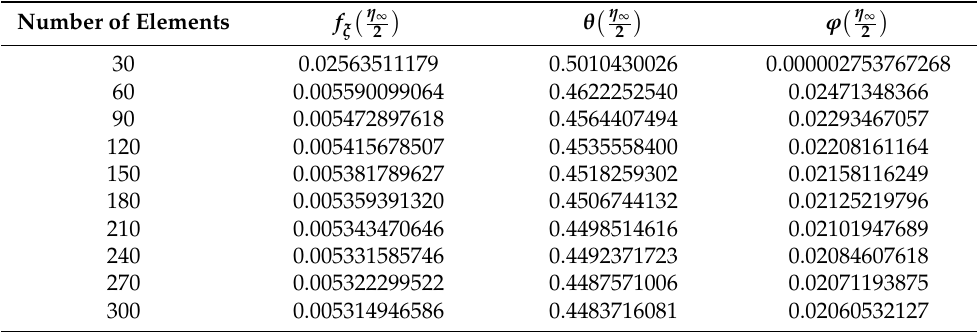
Table 2. Mesh-free analysis of velocity, concentration and temperature at the middle of each of the 300